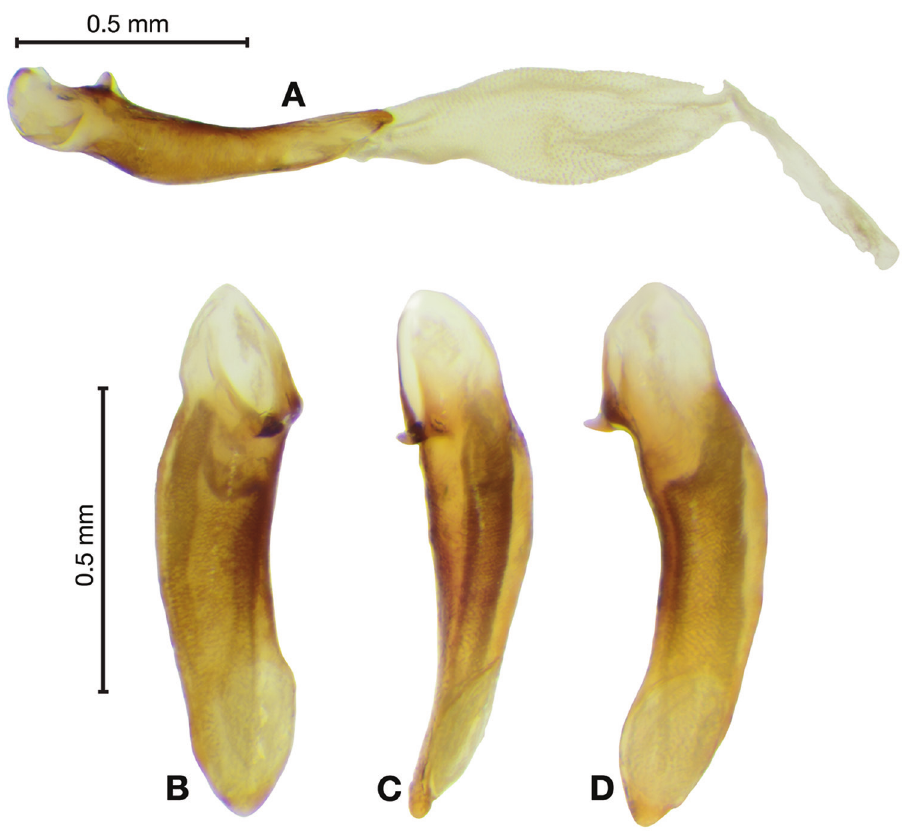
Figure 68. Digital images of male genitalia of Dolichoctis rotundata (Schmidt - Goebel) . A right lateral aspect, endophallus everted B right lateral aspect C ventral aspect D left lateral